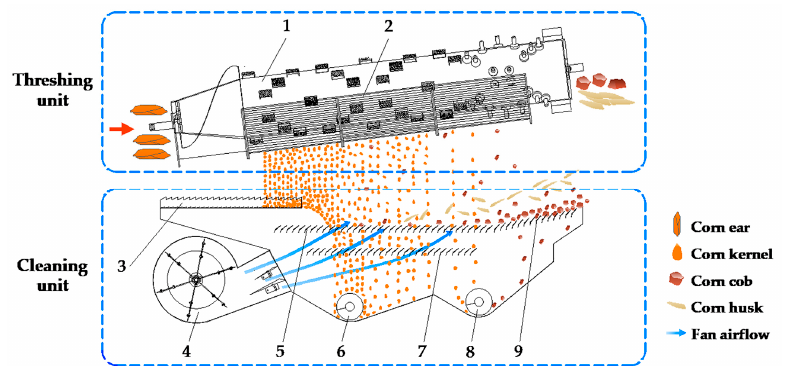
Figure 1. Corn threshing and cleaning system. 1. threshing drum, 2. concave, 3. oscillating plate, 4. fan, 5. upper screen, 6. kernel transport auger, 7. lower screen, 8. impurity transport auger, 9. tailing screen.